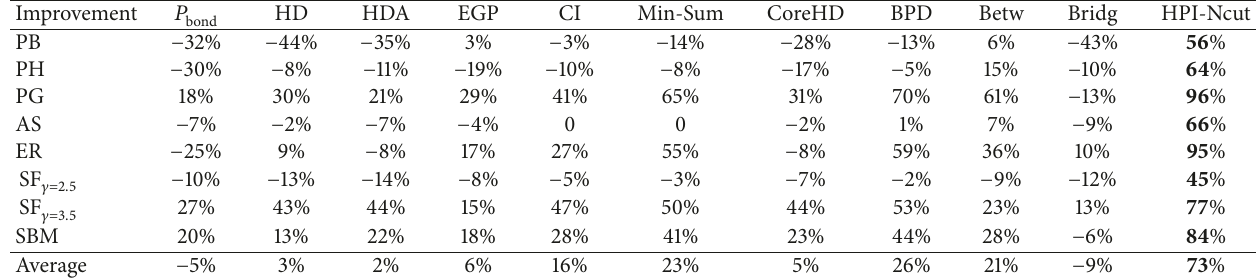
Figure 2: The size of the GCC of the networks versus link removing proportion, comparing with classical node removal-based methods on artificial networks. The results of the site percolation are obtained after 100 independent runs. Table 3: The improvement of the DCFE of each algorithm, comparing with the baseline, that is, site percolation method. The best performing algorithm in each column is emphasized in